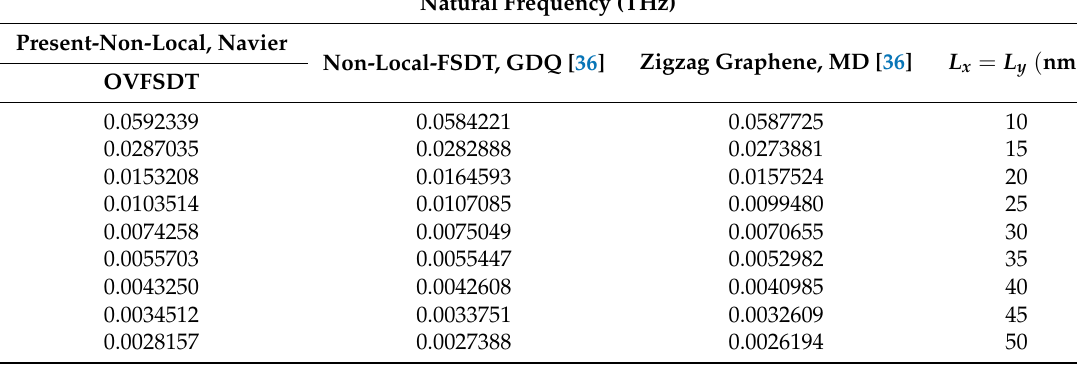
Table 1. Numerical results based on the one-variable first-order shear deformation plate